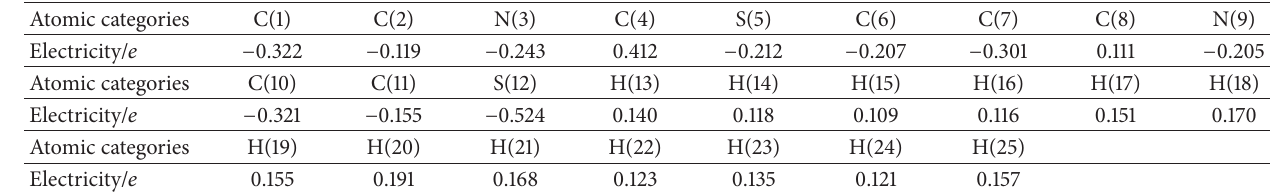
Figure 7: The spatial structure of ethyl xanthate molecules combined with metal ions. Table 2: Each atom Mulliken charge distribution of optimization molecular structure of NND.